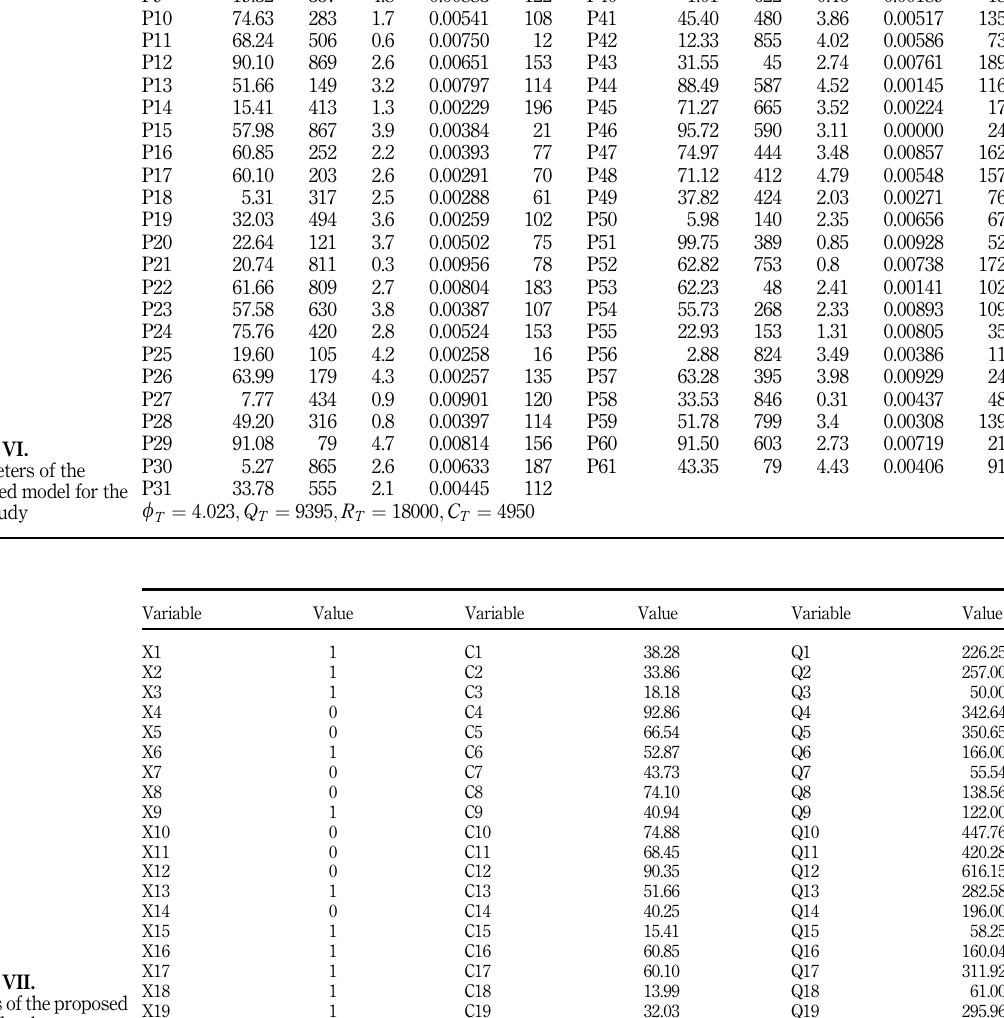
Table VII. Results of the proposed model for the case